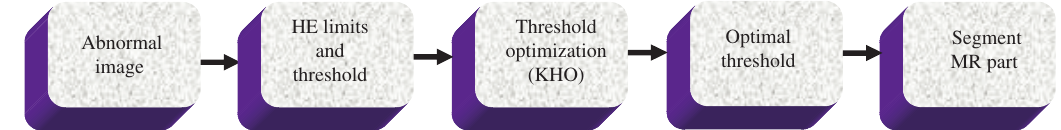
Figure 2: Block Diagram for the Segmentation